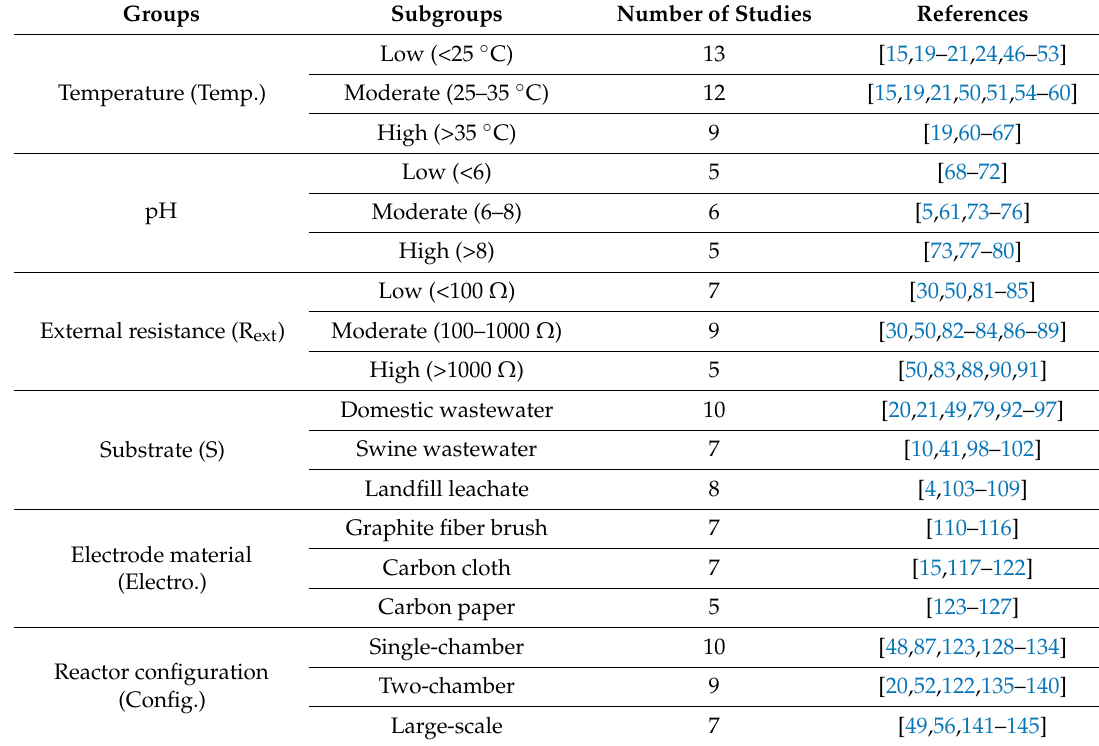
Table 1. Matrix of studies providing data for the data synthesis and